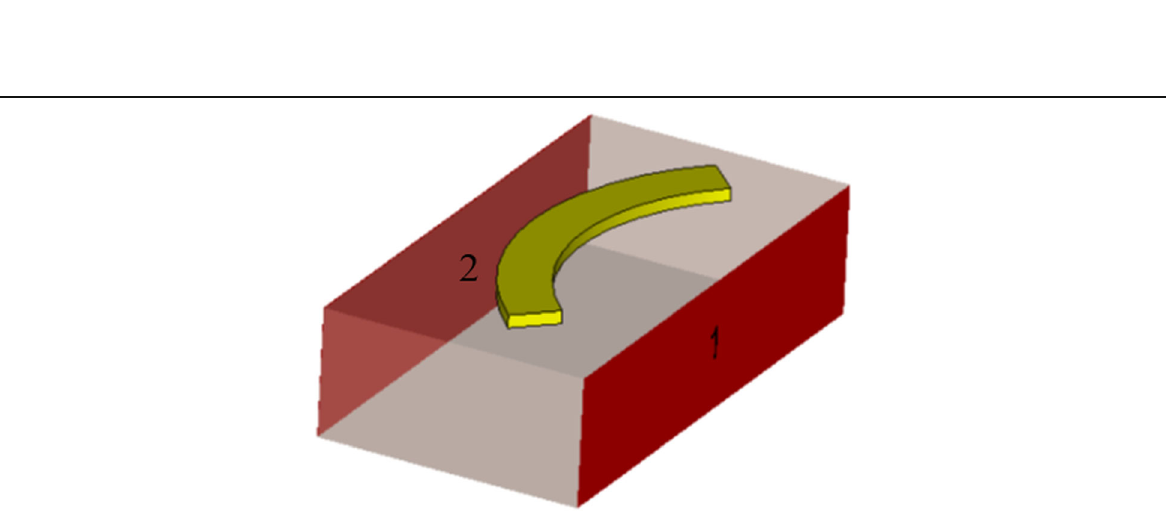
Fig. 11 A single-unit cell of the arc-shaped parasitic